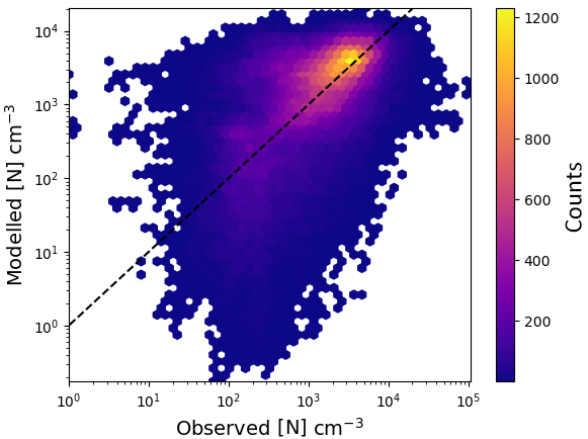
Figure 7. Comparison of particle concentration from EMAC with atmospheric observations for the year 2008. The used stations and their coordinates are in Table 2.